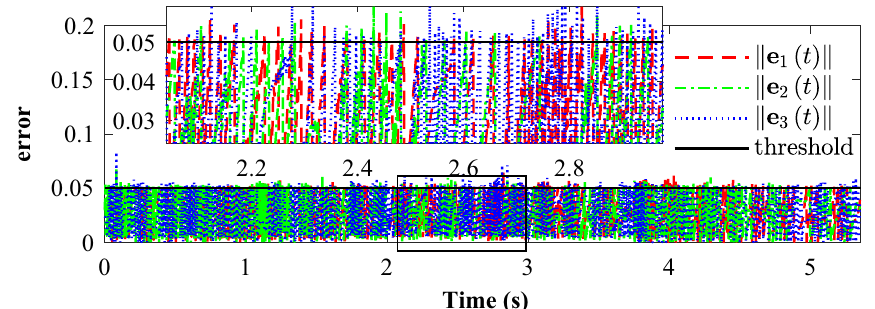
Figure 18. Experimental results: Measurement error for followers.